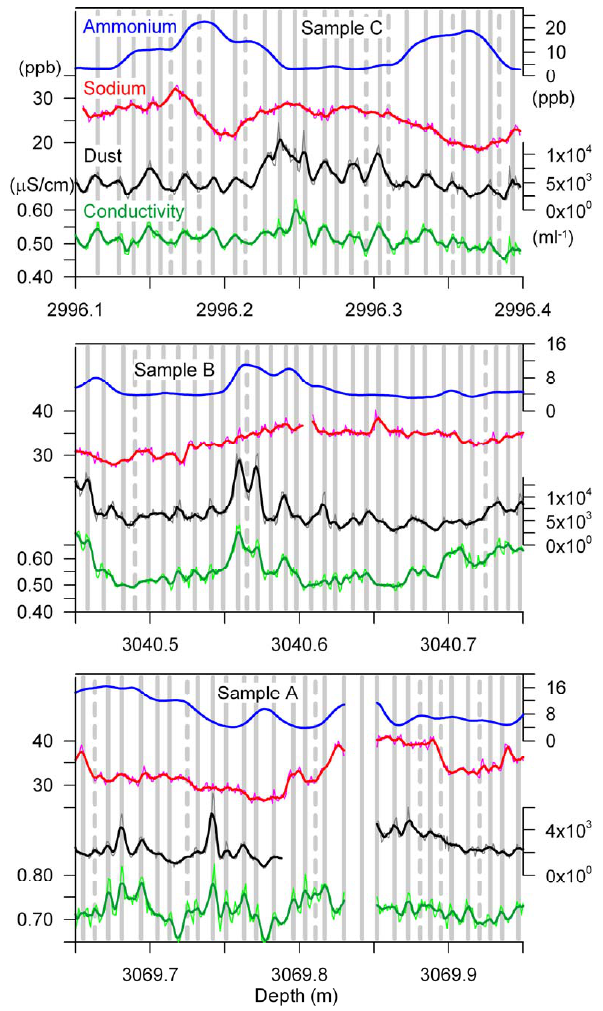
20 Fig. 5. Examples of annual layer counting in samples “A”, “B”, and “C”, respectively. Annual layers are resolved in dust (black) and conductivity (green) and occasionally in sodium (red), whereas the ammonium signal (blue) is affected by post-depositional pro- cesses. “Certain” and “uncertain” annual layers are indicated with solid and dashed grey vertical lines, respectively. The measure- ments are shown in 1mm resolution (thin light curves) as well as in 5mm smoothed resolution (thick dark